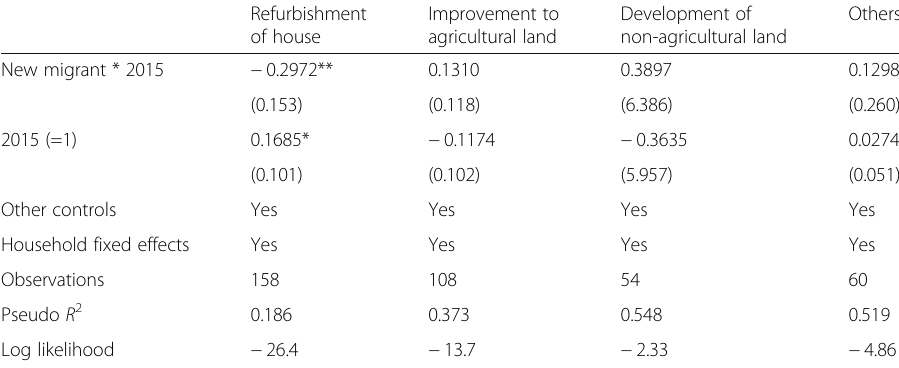
Table 7 Effect of having a new migrant on likelihood to invest in different activities